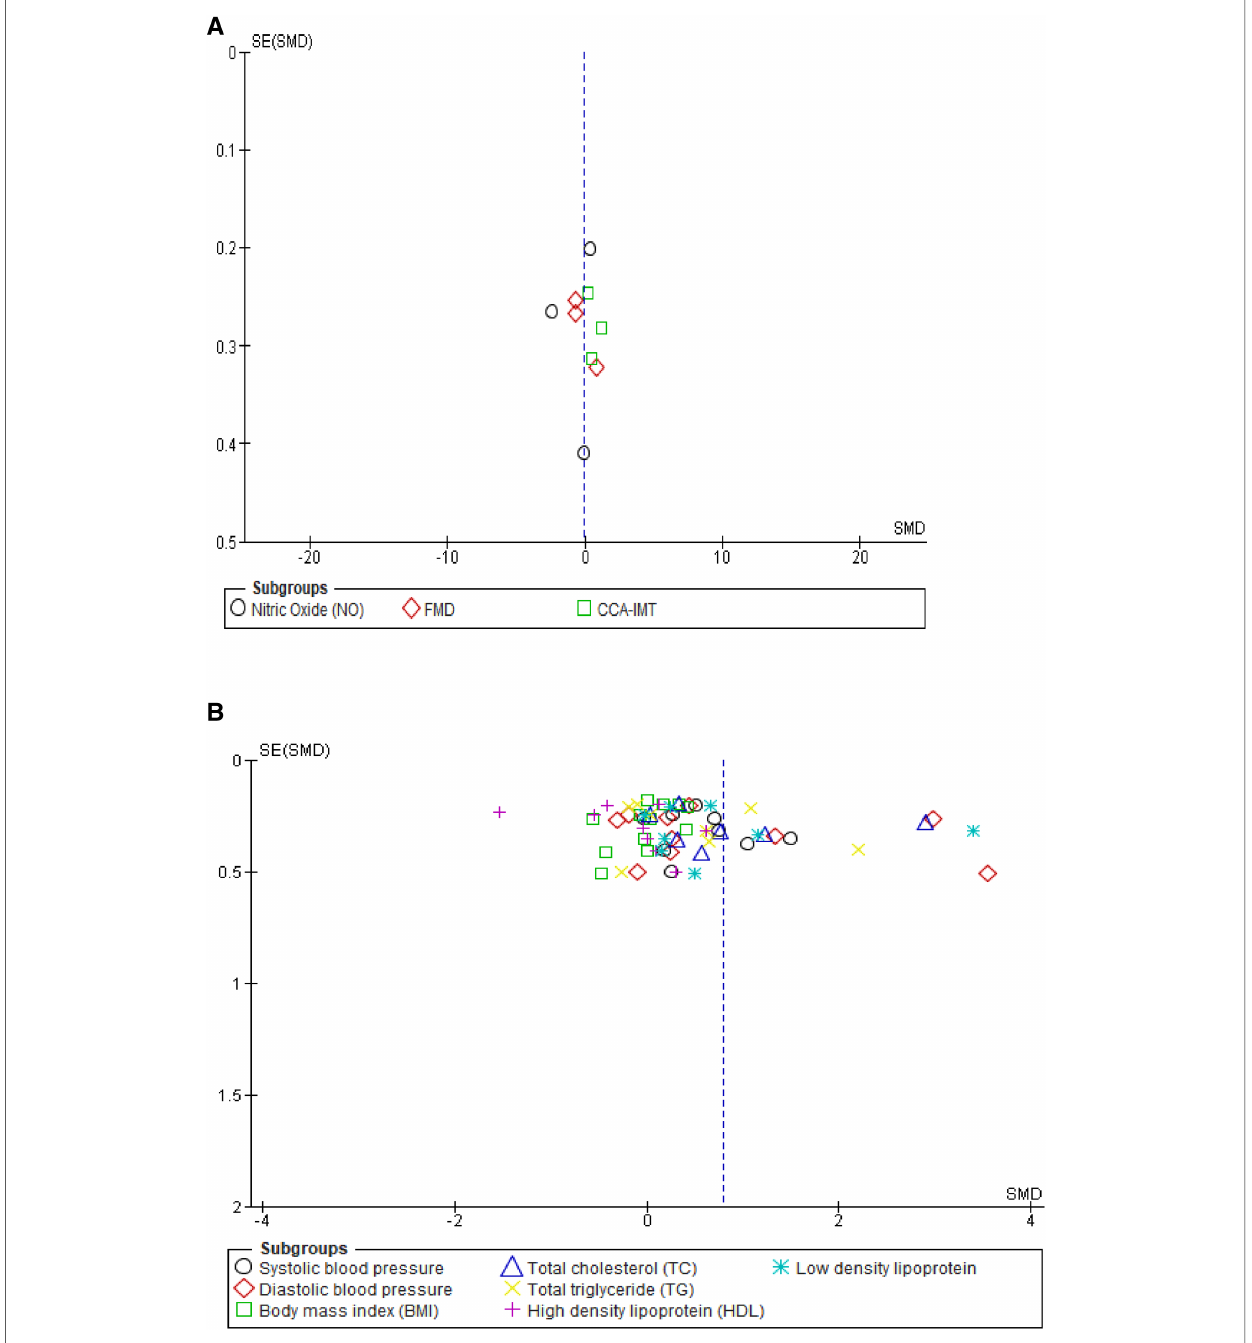
FIGURE 4 Funnel plot of vascular markers and cardiovascular risk factors showing a perfect symmetry. Hence, there was no publication bias in these studies. ( A ) Vascular markers, ( B ) Traditional cardiovascular risk